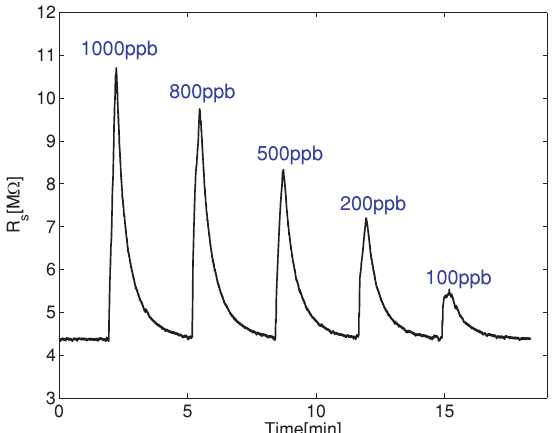
Figure 6. The time response of the gas sensor with t inj = 30 s and t ret = 3 min for 5 different concentrations of nitric oxide.